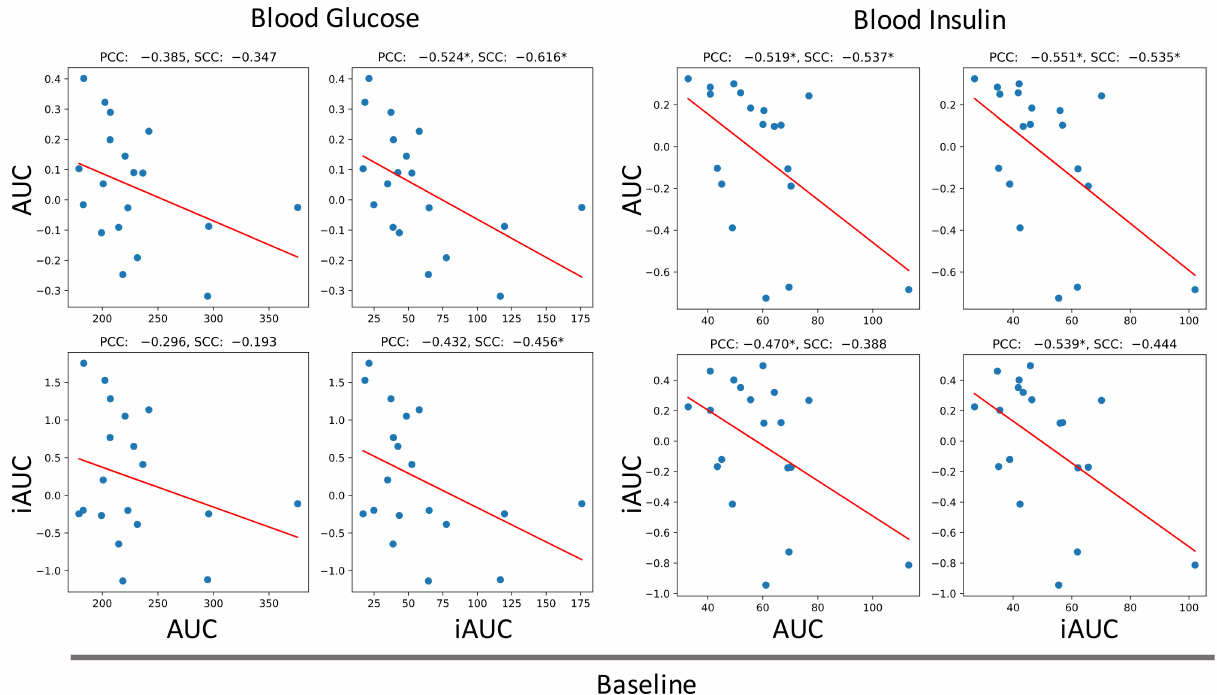
Figure 3. Improvement of glucose tolerance score by barley intake depends on glucose tolerance score at baseline. X axis indicates glucose tolerance index at baseline and Y axis indicates responder score. PCC: Pearson correlation coefficient, SCC: Spearman correlation coefficient, * p < 0.05, no correlation